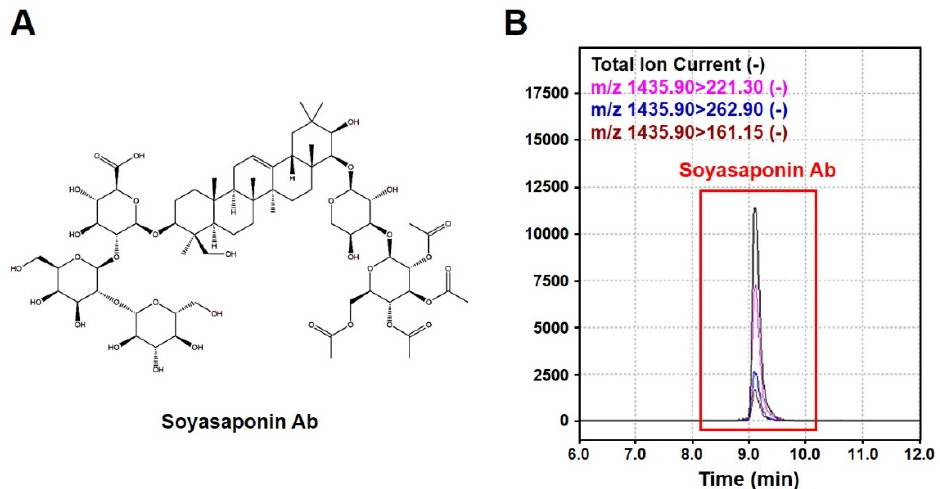
Figure 1. Analysis of soyasaponin Ab contents in the germinated soybean embryo extract (GSEE) using HPLC/MS/MS: ( A ) chemical structure of soyasaponin Ab; ( B ) HPLC chromatogram of soyasaponin Ab in the GSEE.